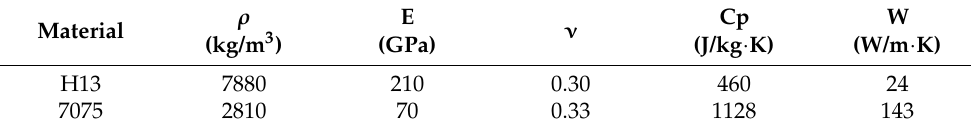
Table 5. Calibrated friction coefficient FS and FD.